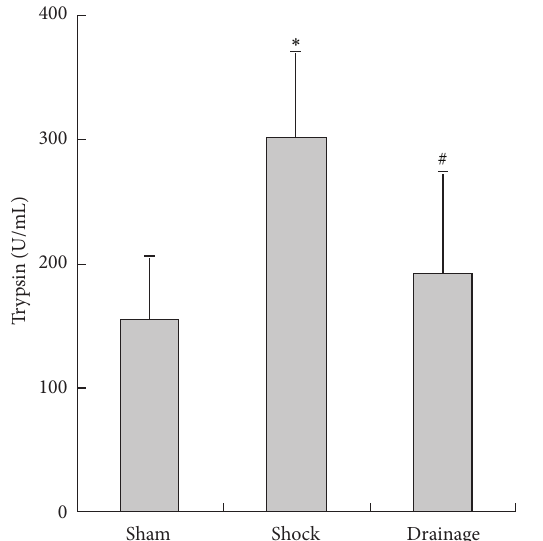
Figure 3: Effects of mesenteric lymph drainage on trypsin activity of plasma in hemorrhagic shock rats without resuscitation (U/mL, mean ± SD, 𝑛 = 6 ). ∗ 𝑃 < 0.05 versus sham group; # 𝑃 < 0.05 versus shock group.